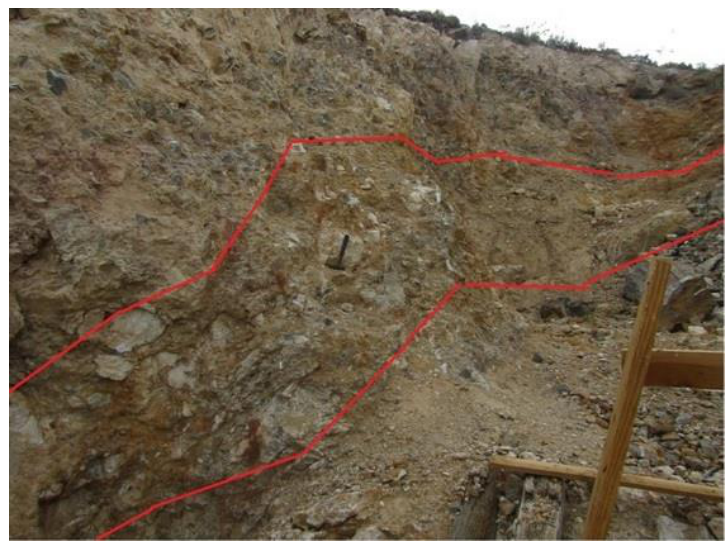
Figure 10. Outcrop of barite mineralization within a zone with iron oxides and clays located in profile 5. The red line indicates the possible limit of barite mineralization.